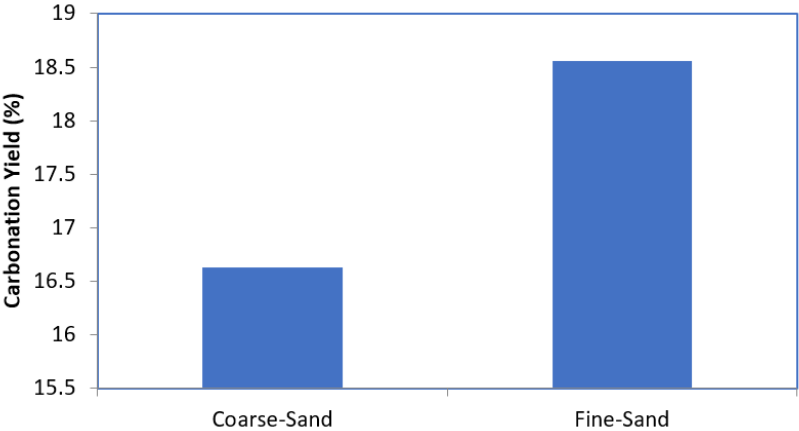
Figure 5. Carbonation yield at 5 bar pressure, 64 h carbonation time and 40 h curing time.